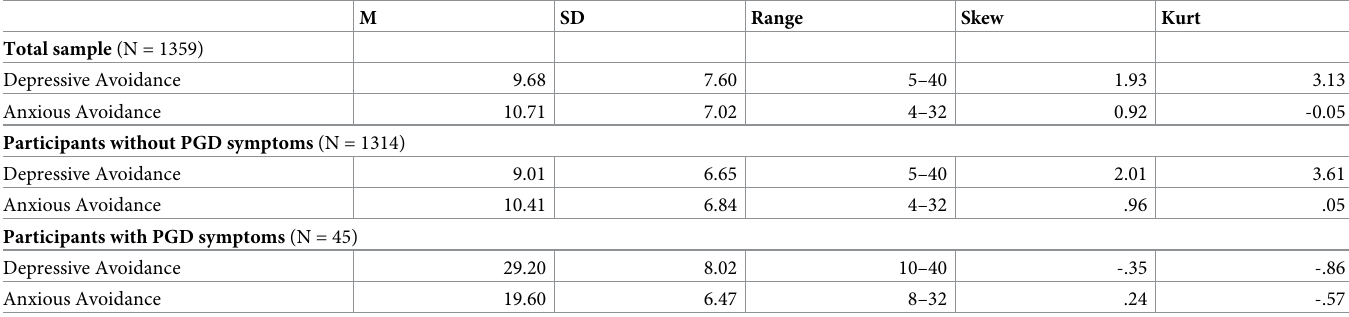
Table 4. Descriptive data of the DAAPGQ subscales.